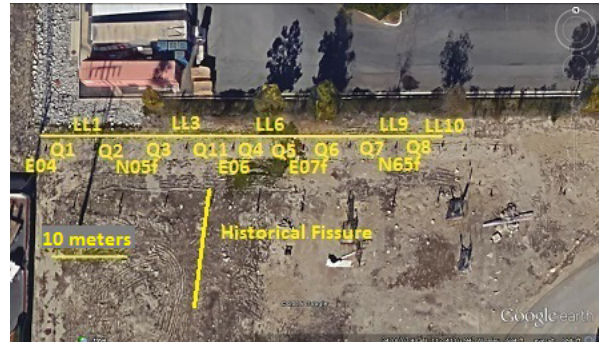
Figure 1. Instrument layout at 5500 Daniels horizontal extensome- ter site, Chino, California. Q1–Q8 are quart-tube horizontal exten- someters. LL1-LL10 are liquid-level sensors. E04-N65f are biaxial tilt sensors.